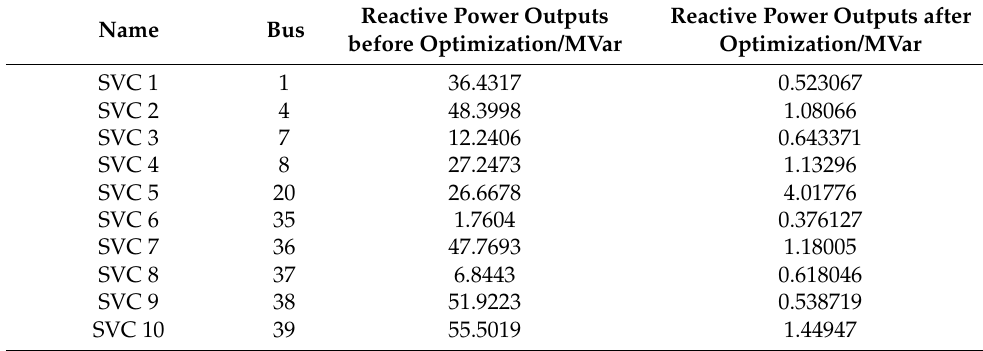
Table 6. Comparison of SVC reactive power outputs before and after